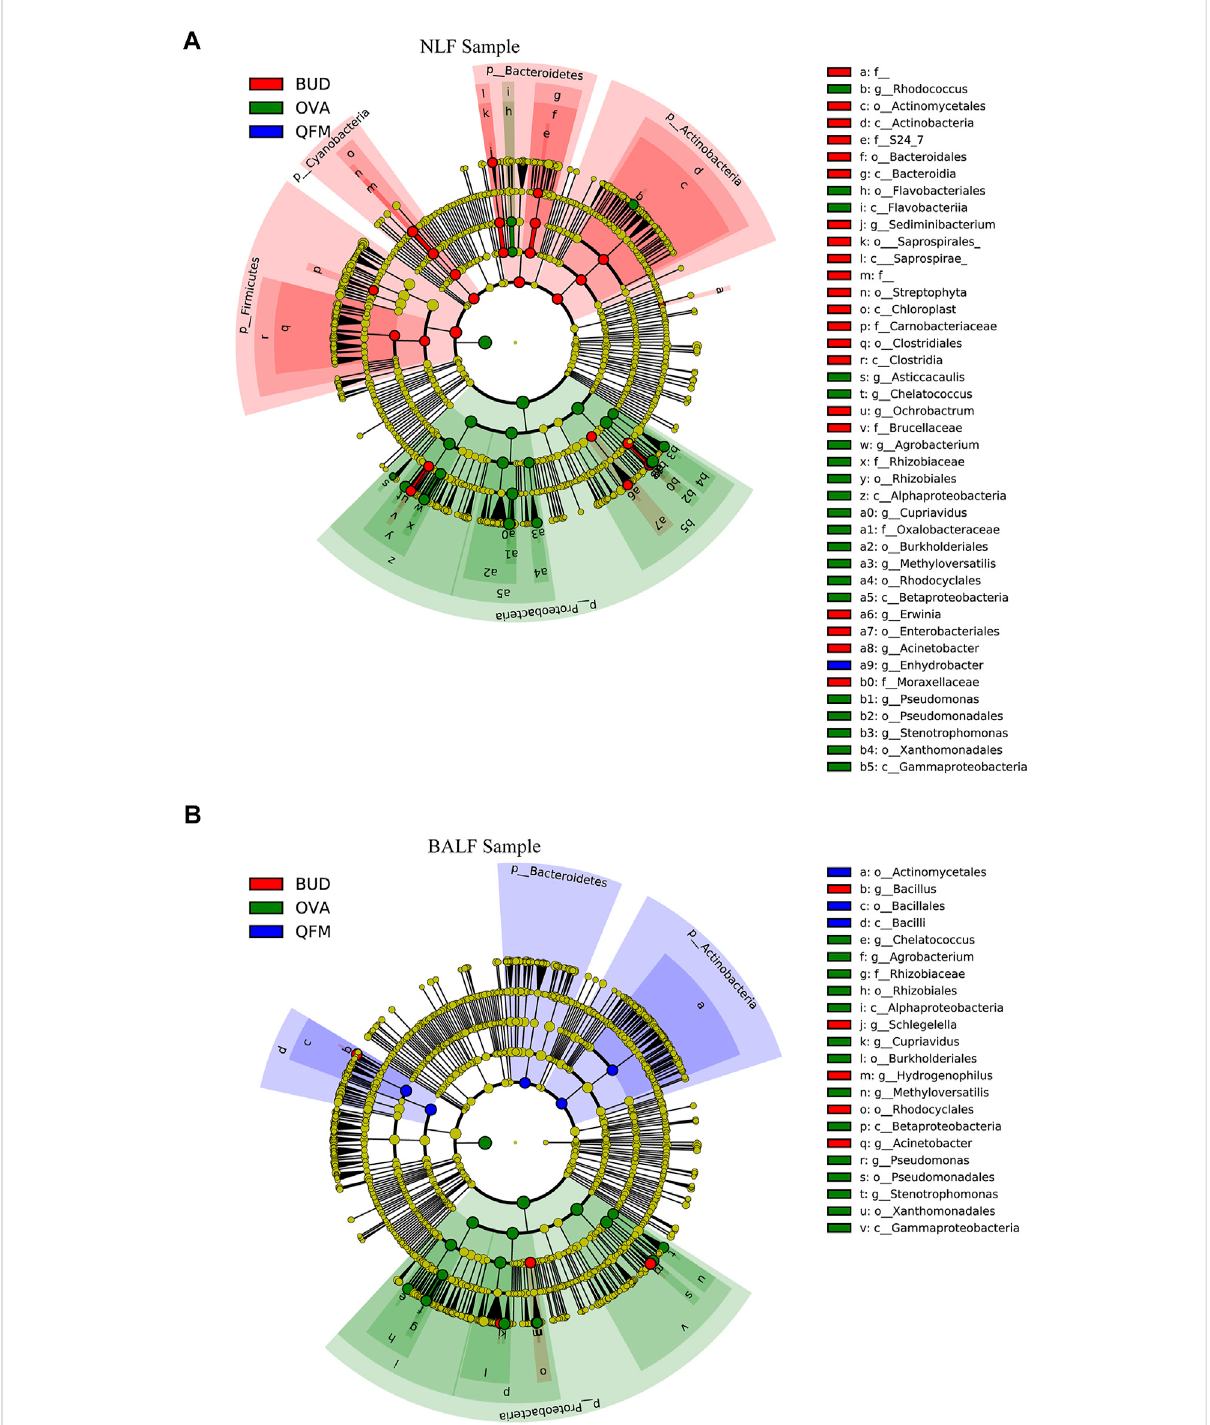
FIGURE 6 Different abundances of bacterial communities in the respiratory samples, as indicated in LEfSe analysis. The differences are indicated by the color of over-represented taxa: green indicating ovalbumin (OVA)-induced mice, blue indicating Qingfei oral liquid medium concentration (QFM) treated mice, and red indicating budesonide (BUD) treated mice. (A) Different abundances of bacterial communities in the upper respiratory tract (URT) (nasal lavage fl uid (NLF) samples) with LDA scores > 2.5. (B) Different abundances of bacterial communities in the lower respiratory tract (LRT)(bronchoalveolarlavage fl uid(BALF)samples)withLDAscores > 3.0.Thecirclesrepresentphylogeneticlevelsfromphylum(innermostcircle)to genera (outermost circle). n = 5 in each group; adjusted p values ≤